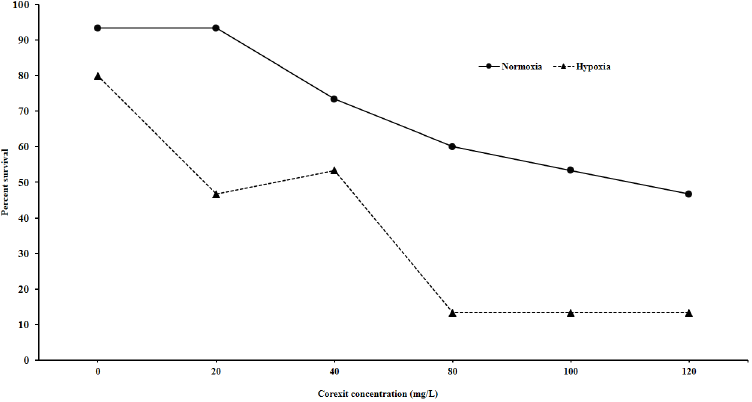
Fig 1. Effects of hypoxia on Corexit-induced acute toxicity in sheepshead minnow larvae. Statistical analysis by 2-way ANOVA demonstrates that both oxygen level and concentration have significant effects on survival (p < 0.001) but their interaction is not significant (p =